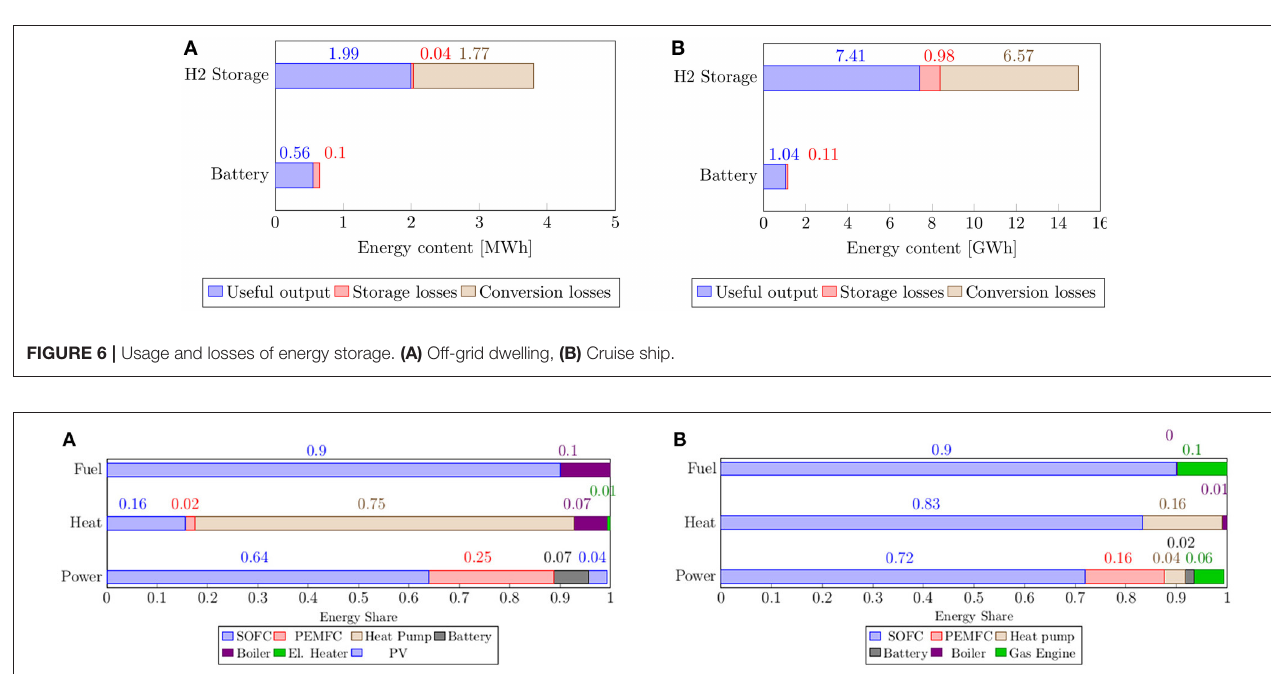
resulting from a compromise of what reported by Cohen et